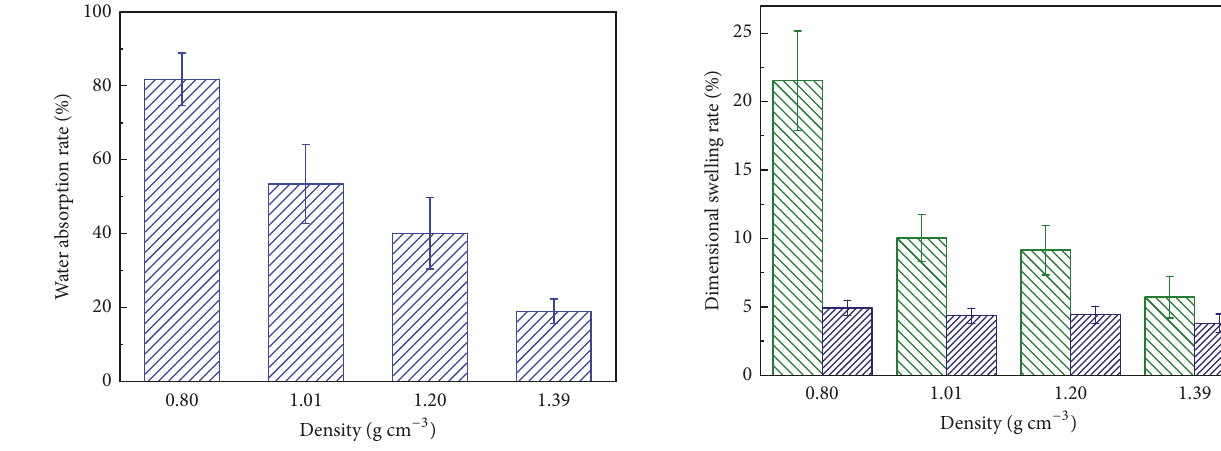
Figure 8: Water absorption rate of scrimbers with different densi- ties.